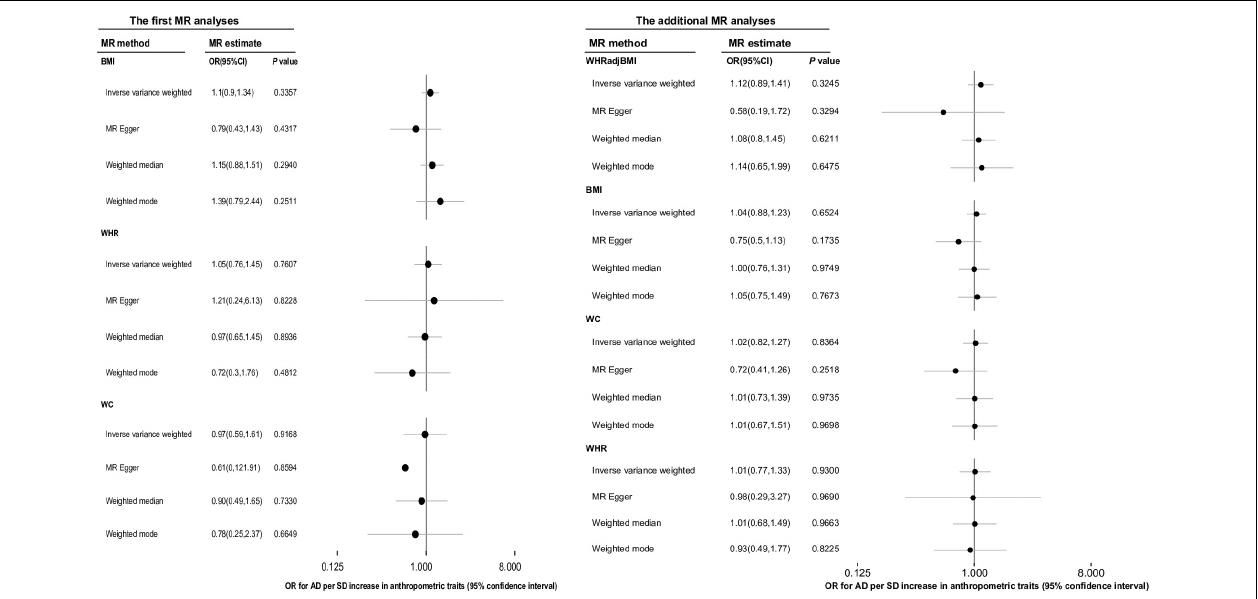
FIGURE 3 | The overall causal effect of body shape on the risk of Alzheimer’s disease from each of four different methods (inverse-variance weighted method, MR-egger regression method, weighted-median method and weighted-mode method). Results were reported as the odd ratio (OR) of AD per 1-SD increase in each anthropometric trait. The results of additional MR analyses were the more reliable causal estimates of ATs on AD, and the causal effect of WHRadjBMI on AD was displayed in this column was just for easy reading. MR, Mendelian randomization; AD, Alzheimer’s disease; AT, anthropometric traits; BMI, body mass index; OR, odds ratio; WC, waist circumference; WHR, waist-to-hip ratio, WHRadjBMI, waist-to-hip ratio adjusted for body mass index.